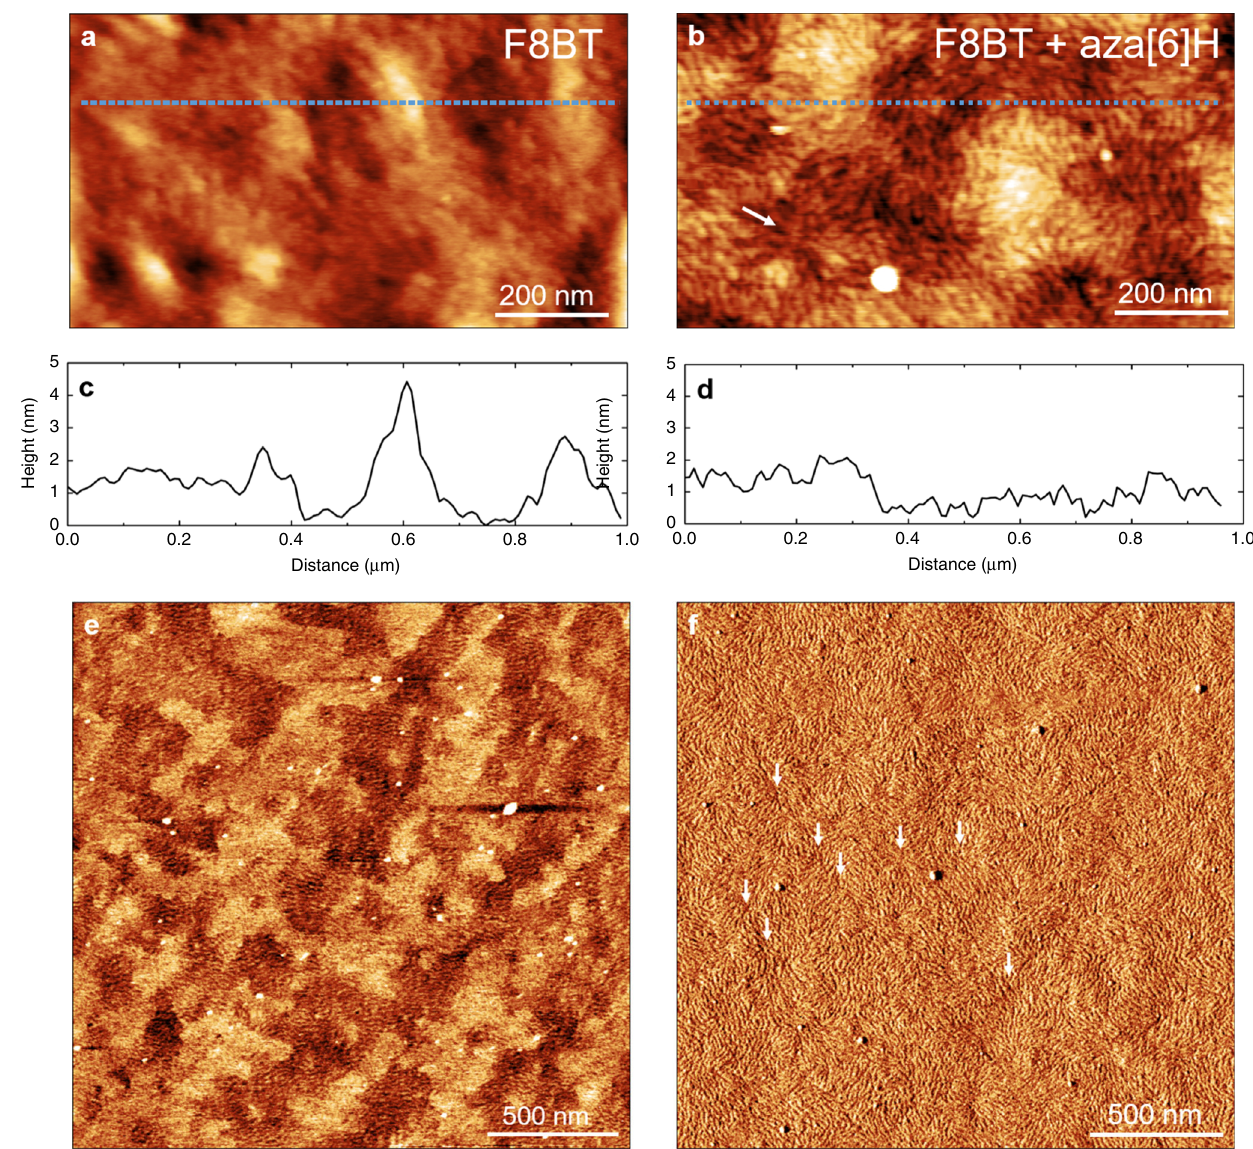
Fig. 5 AFM images of annealed ACP and ACPCA thin fi lms. Topographic AFM images of ( a ) F8BT and ( b ) F8BT:aza[6]H annealed fi lms; corresponding height pro fi les ( c , d ) extracted from the upper blue dashed trajectories in ( a ) and ( b ). Phase AFM images of ( e ) F8BT and ( f ) F8BT + aza[6]H annealed fi lms. Images ( b ) and ( f ) show topological defects highlighted with white